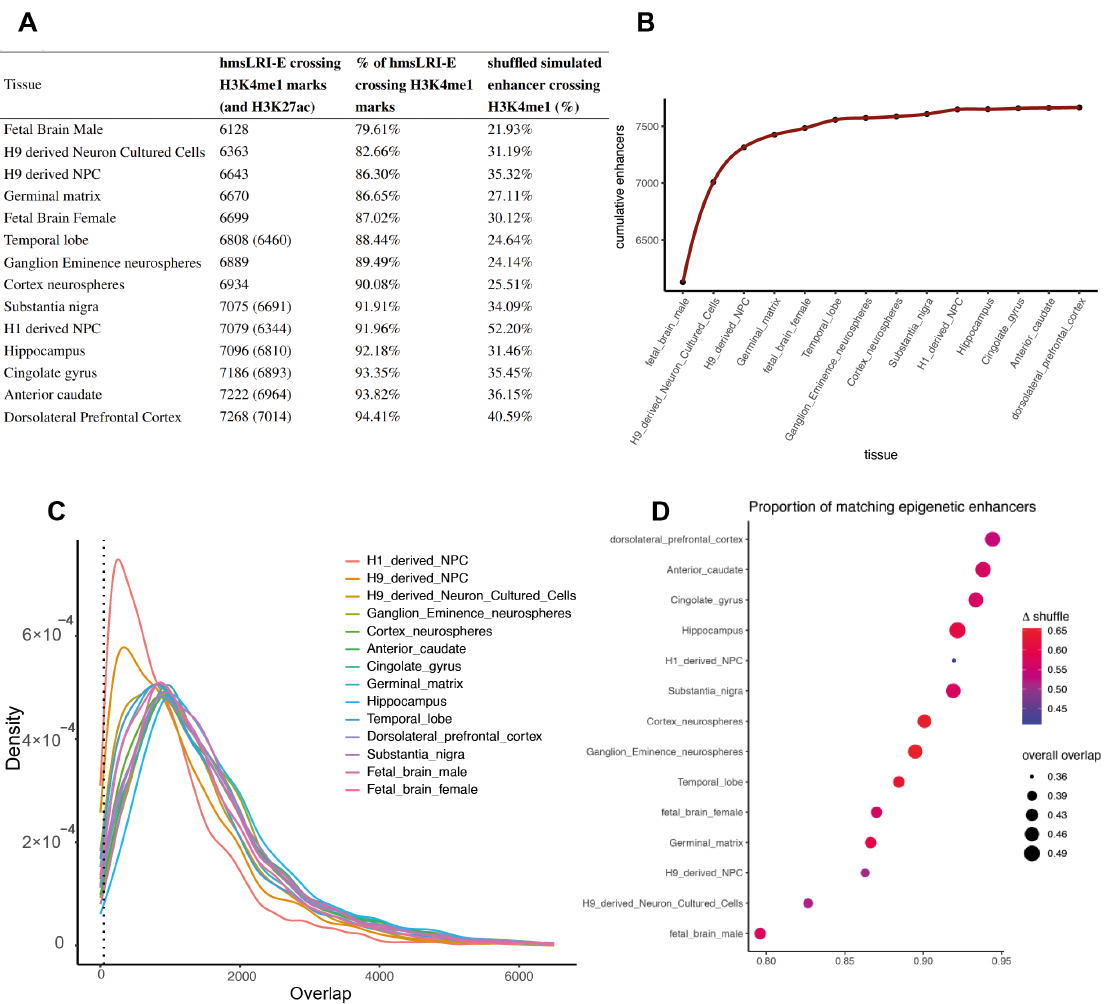
Figure 3. Concordance between hmsLRI-E and human DNA regions carrying epigenetic enhancer marks (H3K4me1; H3K27ac) from Roadmap Epigenomics . ( A )—For each human neural tissue, the number of hmsLRI-E encompassing enhancer marks (H3K4me1; H3K27ac where available) and their relative percentages are shown. The values are compared with the % of shuffled enhancer-like regions overlapping H3K4me1 marks. ( B )—Cumulative number of matched hmsLRI-E in all the tissues. On the x-axis, tissues are listed from the one with the lowest number of matching hmsLRI-E to the one with the highest number. The y-axis shows the cumulative number of unique hmsLRI-E that progressively match the epigenetic enhancer marks of the indicated tissue (the percentage for each tissue is added to the ones already found for the previous ones). ( C )—Distribution of the extent of overlap (in base pairs, X-axis) between hmsLRI-E and human regions carrying epigenetic enhancer marks in human cells according to the Roadmap Epigenomic database (“Density” in the Y axis). The dotted line at 50 bp represents the cutoff below which the hmsLRI-E and the enhancer marks were not considered matched. ( D )—Dot plot representing, on the X-axis, the proportion of hmsLRI-E overlapping human DNA regions (min 50 bp) carrying epigenetic enhancer marks in human neural cells (“matching epigenetic enhancers”), as previously defined in the Roadmap Epigenomic database, in the various tissues indicated on the Y-axis. The width of the dots represents the proportion of bp covered by the methylation region out of the total length of the matched hmsLRI-E. Color is dependent on the difference (delta) between the match of the hmsLRI-E with H3K4me1-marked regions and the match of the simulated shuffled enhancers, in terms of